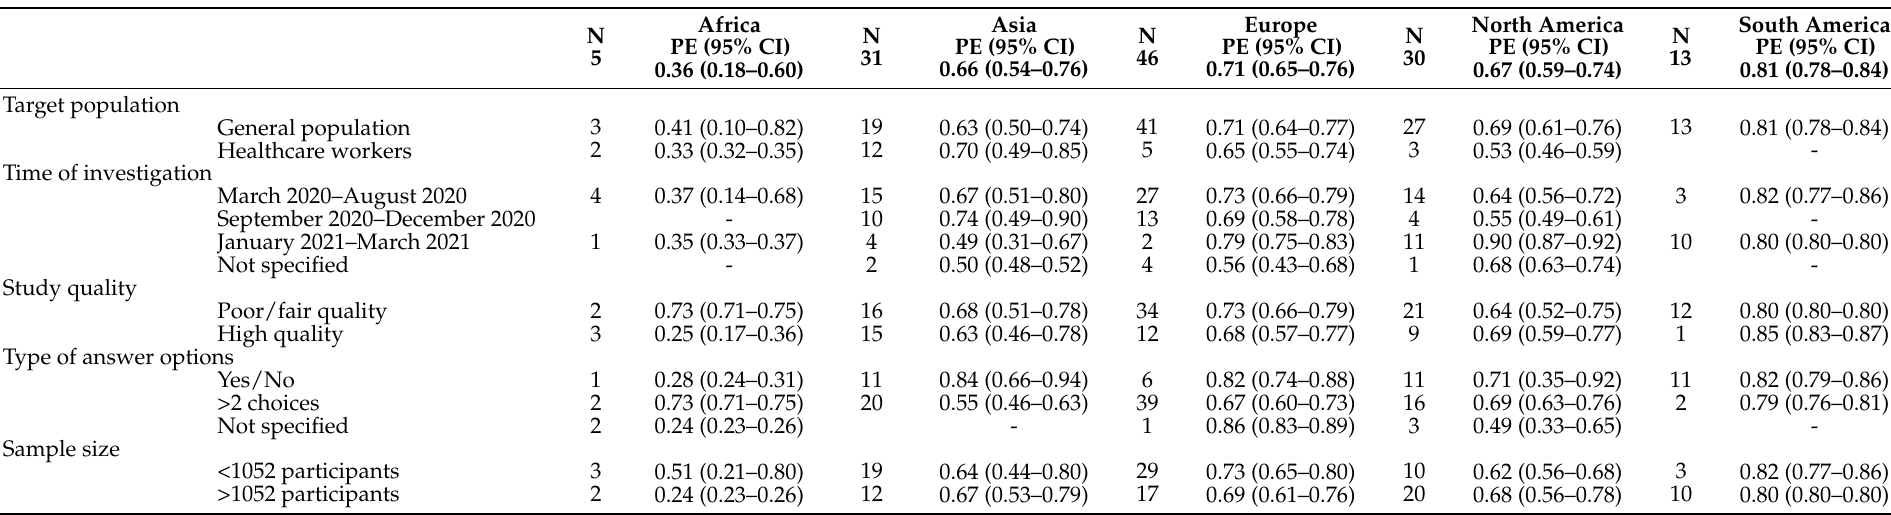
Table 2. Pooled Prevalence Estimates (PEs) and their 95% Confidence Interval (CI) of COVID-19 vaccination acceptance by geographical